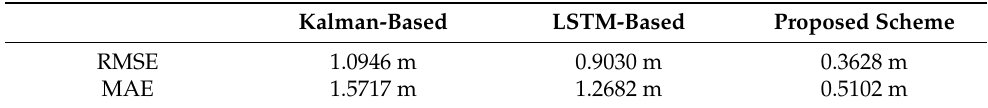
Table 5. Performance of the localization scheme for different tracking models.